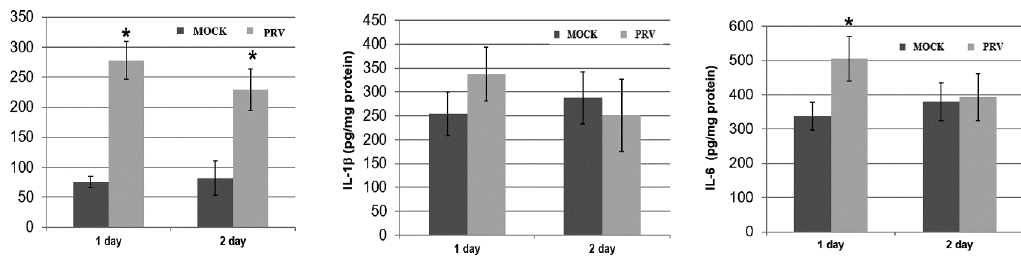
Figure 5. PRV-induced TNF- α , IL-1 β and IL-6 expression in the brains of PRV-infected mice. Mice in the uninfected MOCK group and 24 or 48 h after infection with 10 5 PFU PRV were sacrificed, and the expression levels of these cytokines in the brain were detected by ELISA. Data are expressed as the mean ± SD ( n = 6). * p < 0.05 compared with the MOCK group, respectively.